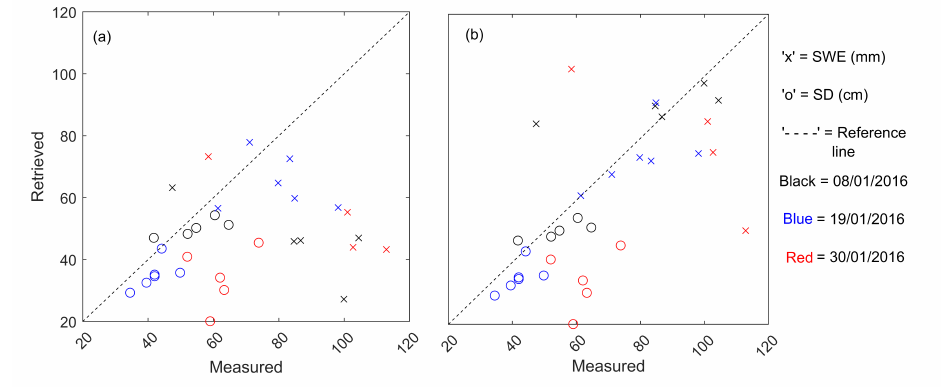
Figure 6. (a) Validation plot for snow depth (SD) and snow water equivalent (SWE) retrieved using the proposed algorithm. (b) Snow water equivalent (SWE) calculated by multiplying the field based density and retrieved snow depth (SD).